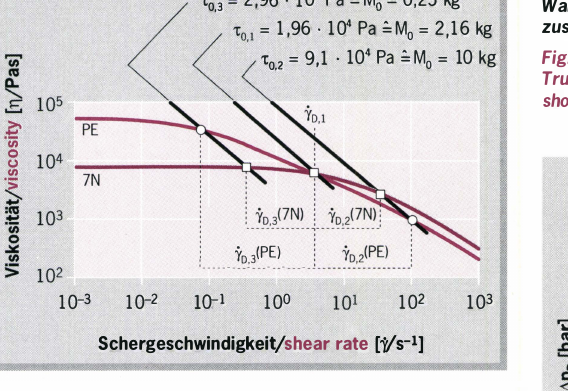
Fig. 7: Bagley plot for determining the entrance and exit pressure losses in a